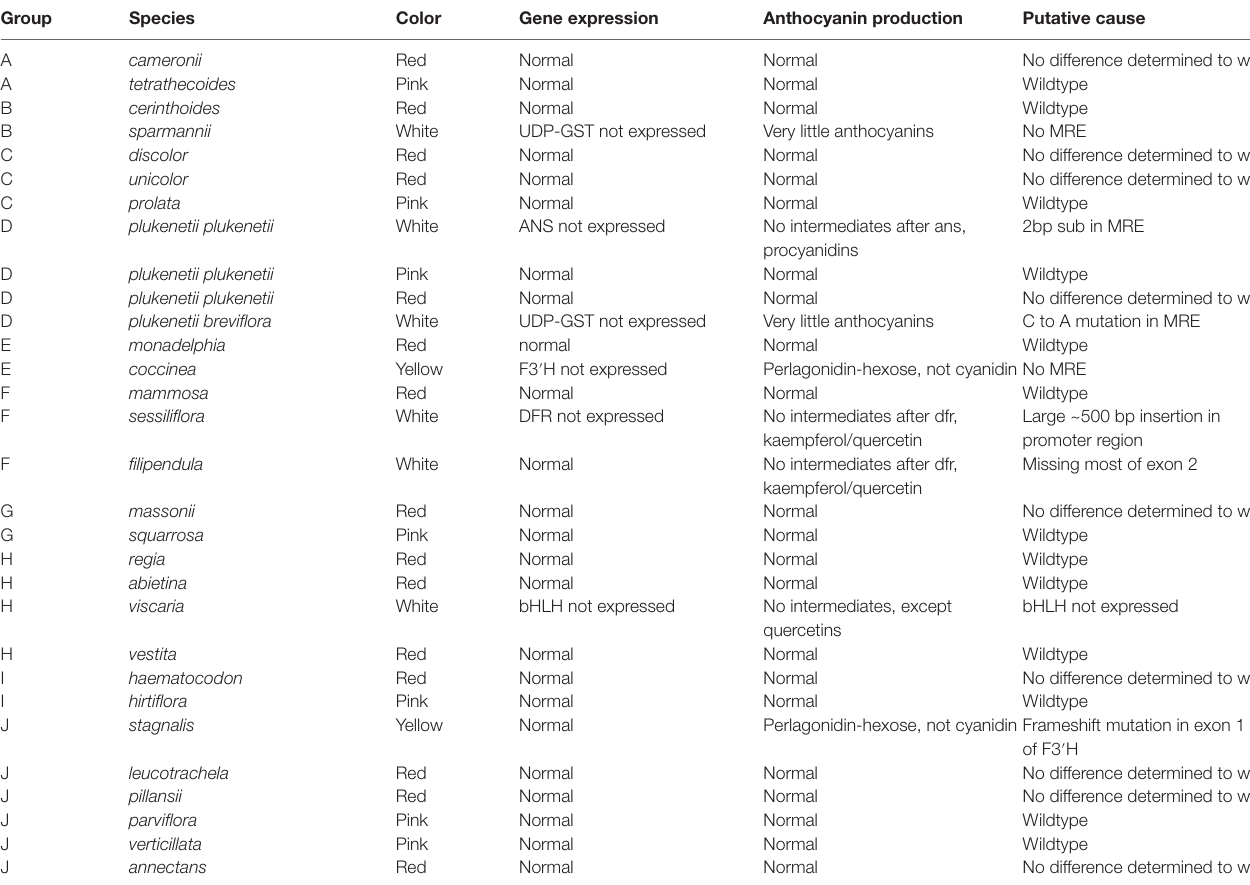
TABLE 2 | The results of the RT-qPCR and UPLC-MS/MS testing on the Erica species that were collected (Le Maitre et al., 2019). MYB recognition element